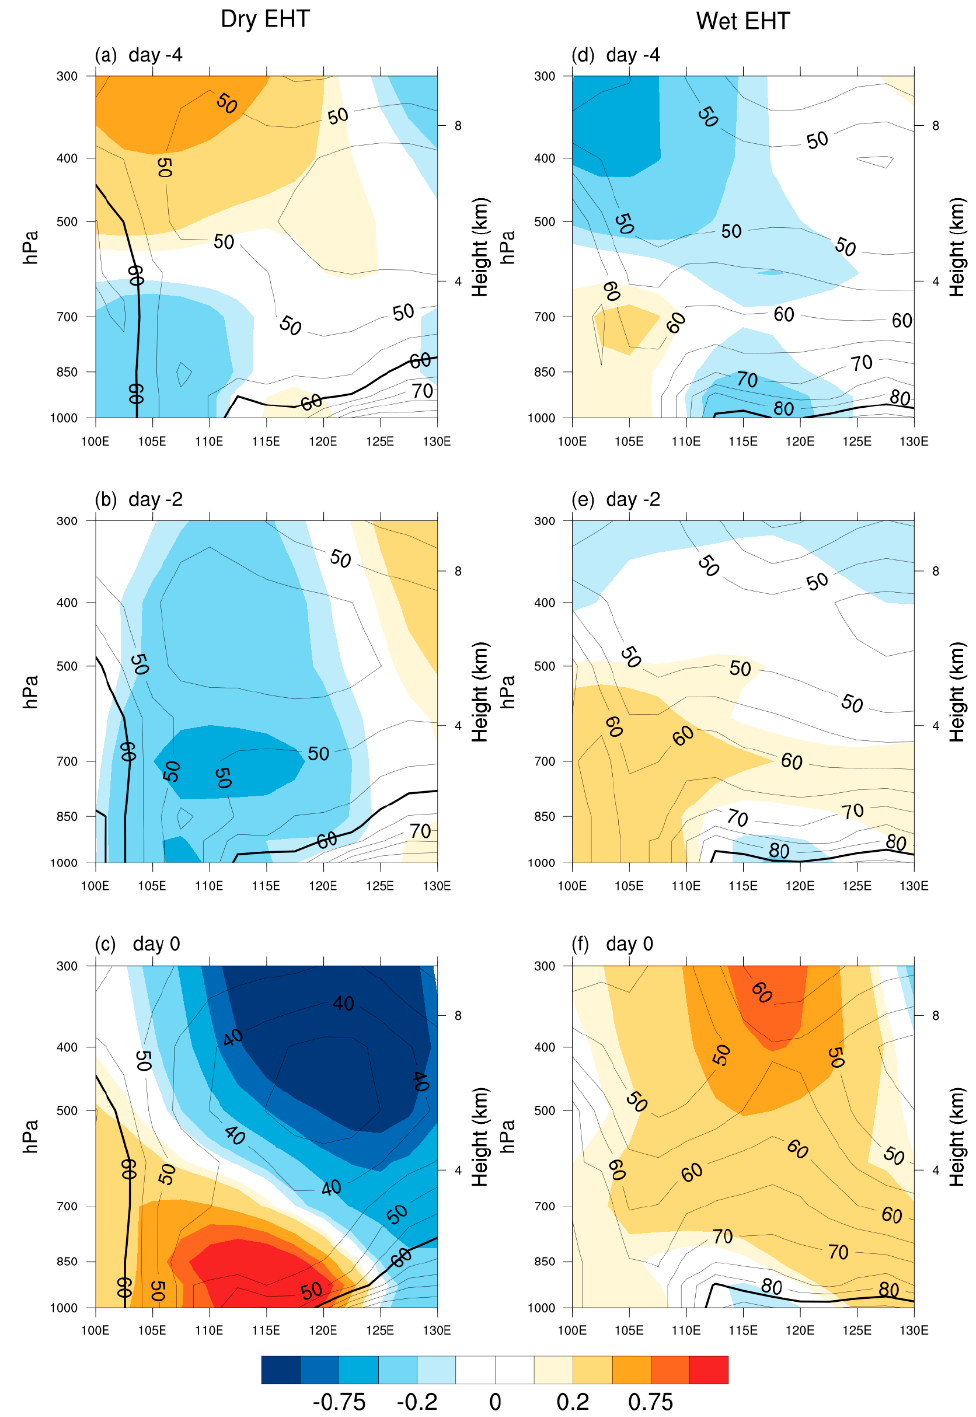
Figure 2. Vertical cross-sections of the average zonal air temperature anomaly (colors; unit: K) and relative humidity (isopleth) from 32.5° to 40° N on dry EHT and wet EHT days in the MLRYR (from day − 4 to day 0 ( a – c ): dry EHT onset days, ( d – f ): wet EHT onset days).